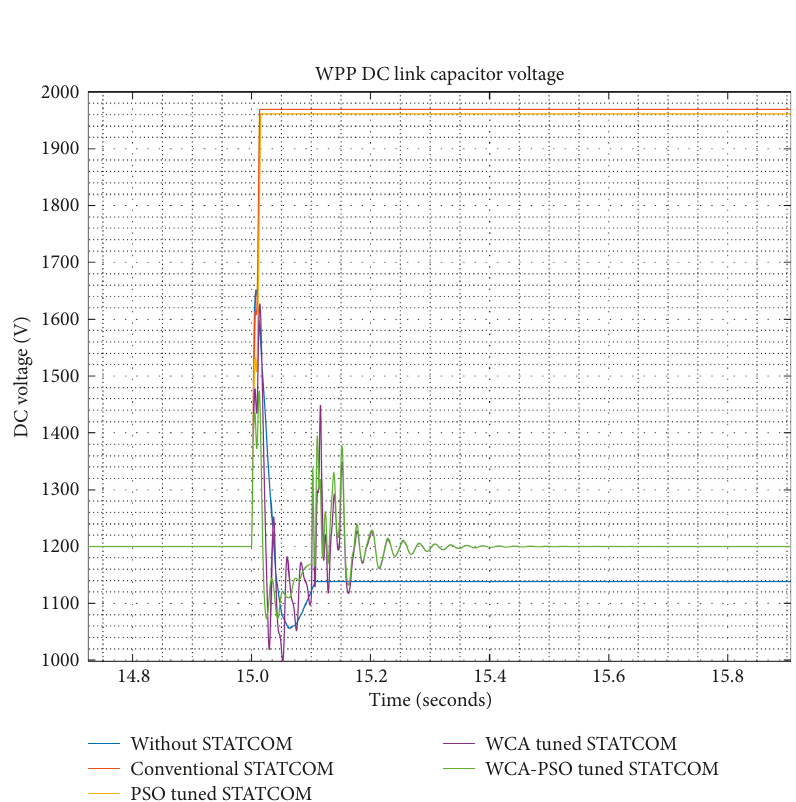
Figure 17: DC link capacitor